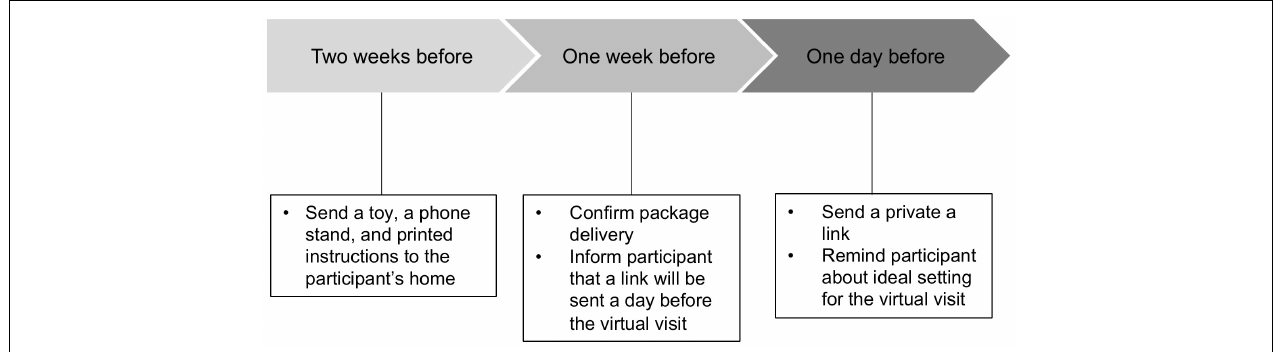
FIGURE 1 | Timeline for virtual visit